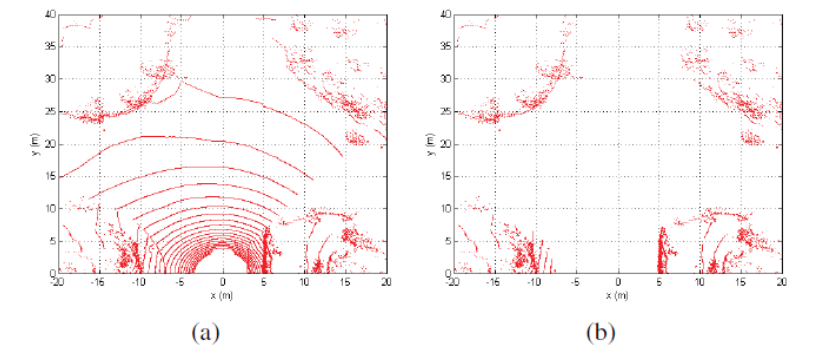
Figure 12. Point cloud segmentation using geometric constraints [50]. ( a ) raw data distribution under the vertical view; ( b ) filtered data distribution under the vertical